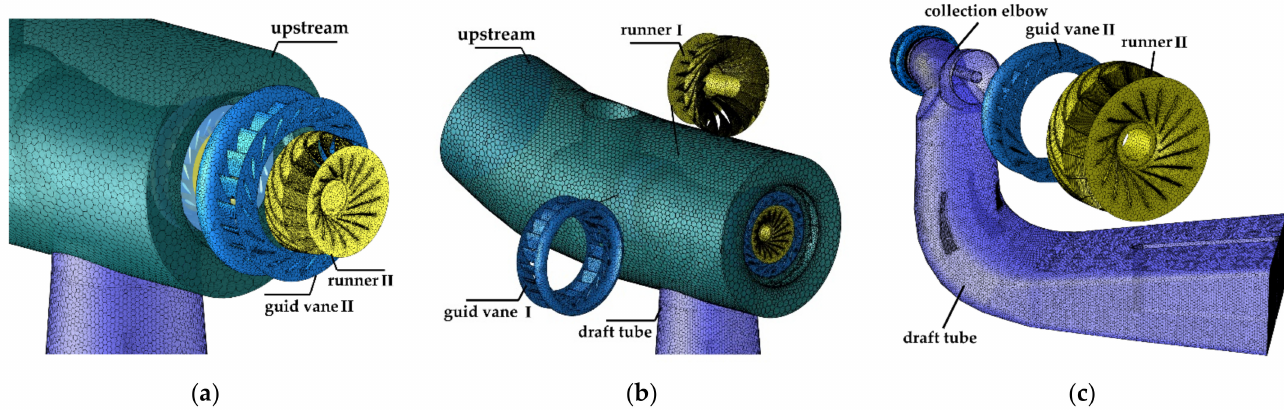
Figure 3. Diagram of mesh division. ( a ) Meshing of runner II guide vane II; ( b ) meshing of runner I guide vane I; ( c ) meshing of collection elbow and dtaft